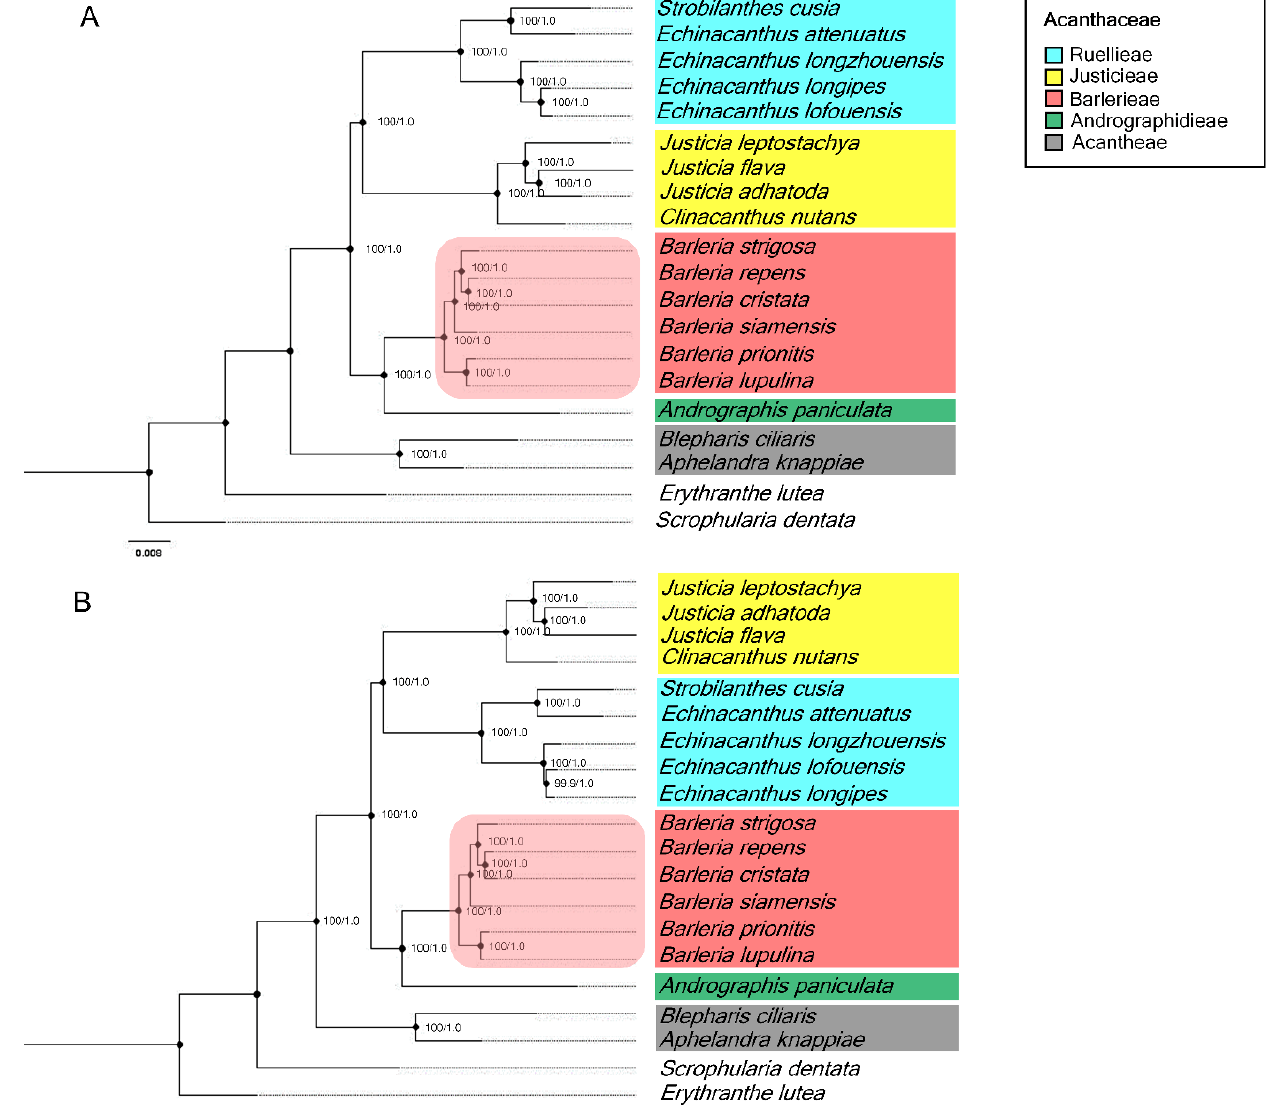
Figure 6. Phylogenetic relationships of the twenty chloroplast sequences inferred from the maximum likelihood (ML) and the Bayesian inference (BI). The numbers associated with each node represent bootstrap support value/posterior probabilities (PPs); ( A ) a phylogenetic tree from the complete chloroplast sequences; ( B ) a phylogenetic tree from the protein-coding sequences (CDSs); the colors were used to classify the Acanthaceae tribes. Two species, Erythanthe lutea (Phrymaceae) and Scrophularia dentata (Scrophulariaceae), were used for the outgroups.